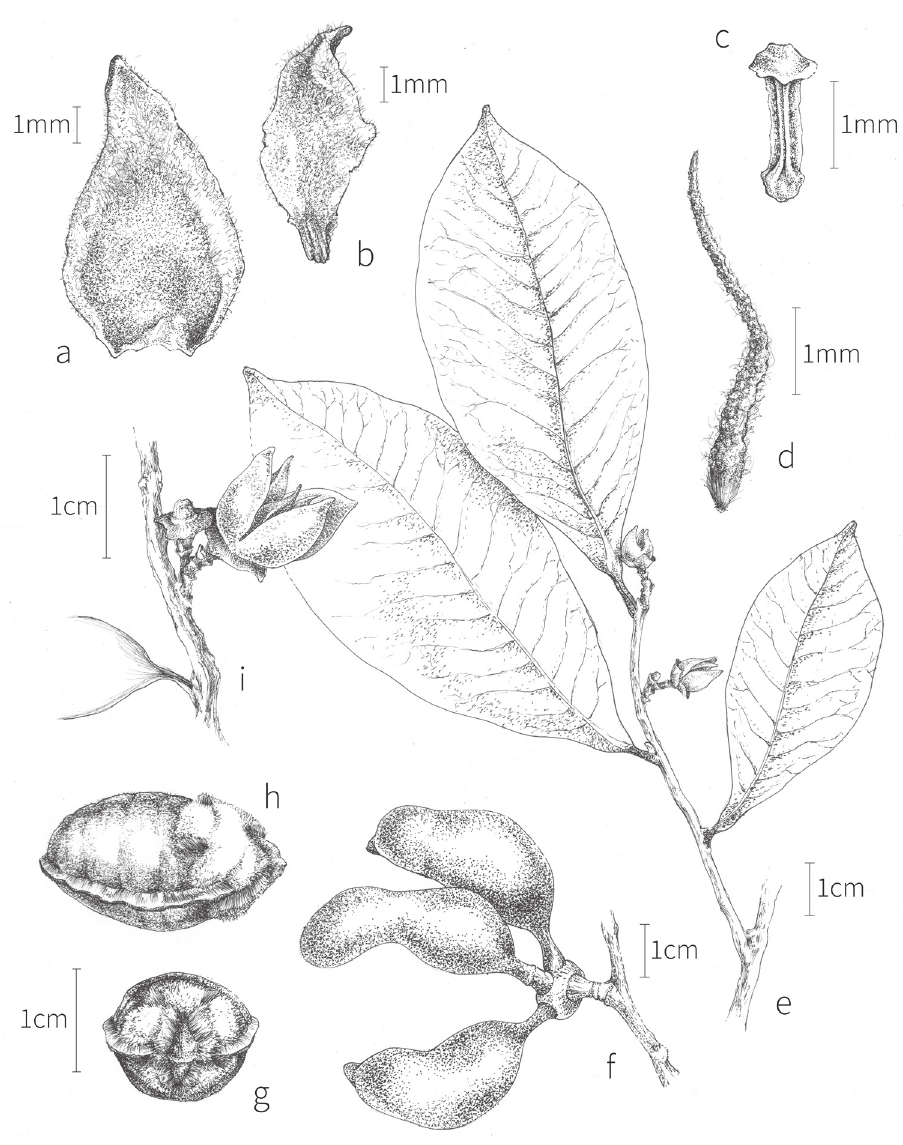
Figure 13. Xylopia staudtii . A Outer petal, adaxial view B Inner petal, adaxial view C Stamen, abaxial view D Carpel E Habit F Fruit G Seed, view of micropylar end H Seed, lateral view I Close-up of in- florescence. A–D from Le Testu 8630 (BM) E, I from Evrard 5212 (BR) F from Reitsma 1071 (WAG) G, H from Reitsma & Reitsma 1168